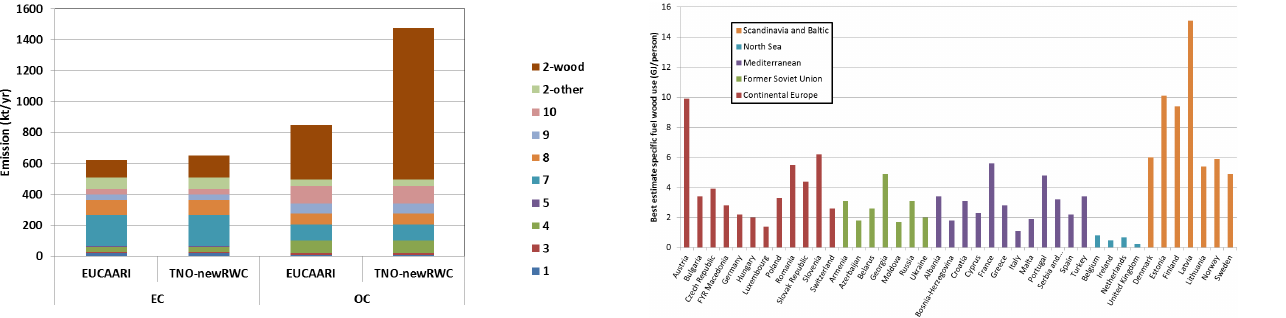
Figure 2. Estimated specific fuel wood use (in GJ person − 1 ) in UNECE Europe grouped by